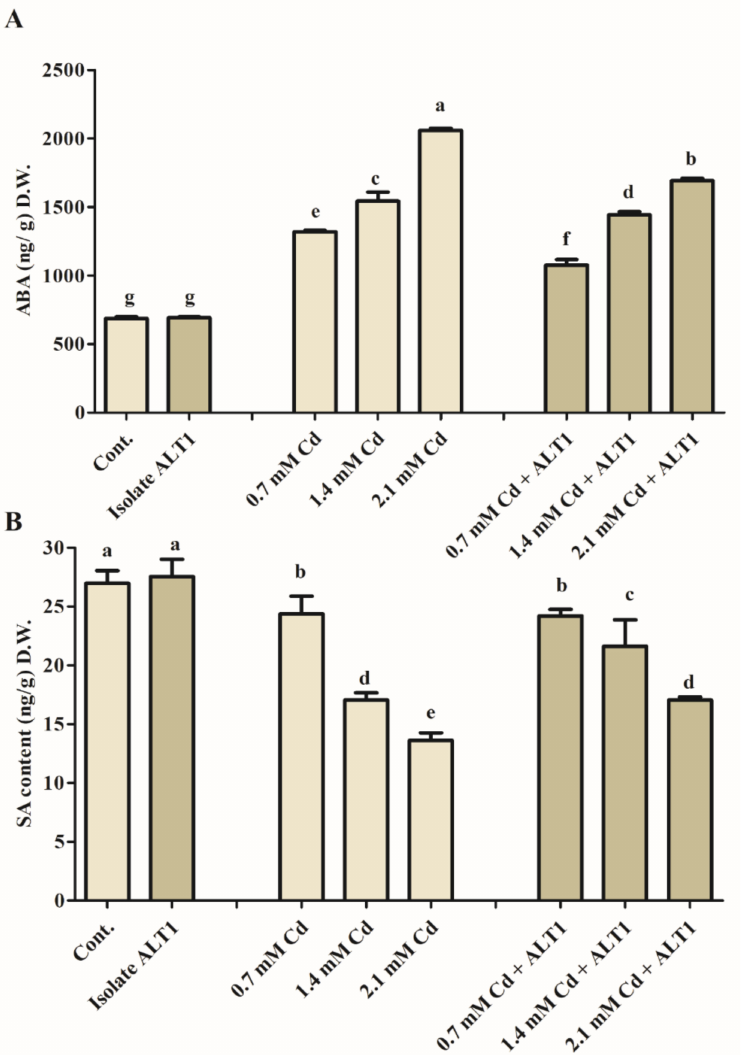
Figure 3. Effect of endogenous phytohormones in ALT1-inoculated and non-inoculated soybean plants. ( A ) Endogenous abscisic acid (ABA) content; ( B ) endogenous salicylic acid (SA) content under normal conditions and cadmium stress. Each data point is the mean of at least three replicates. Error bars represent standard errors. The bars presented with different letters are significantly different from each other as evaluated by Duncan’s multiple range